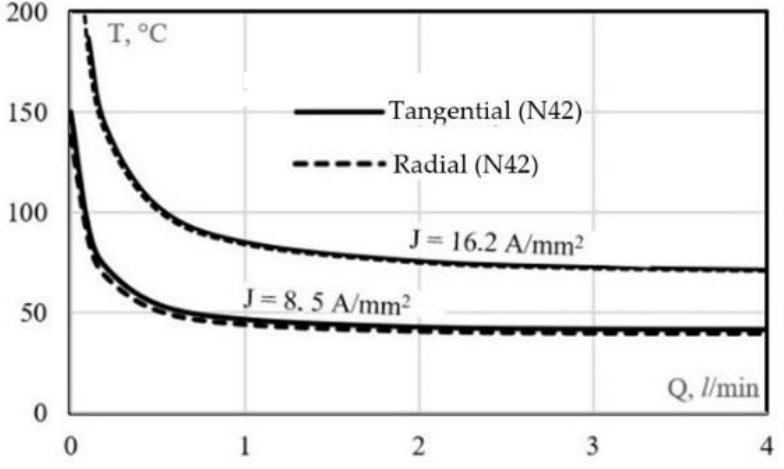
Figure 7. Temperatures of the neodymium magnets (N42) in the tangential and radial machines at various water flow rate of the liquid cooling system. Here, the X -axis defines the flow rate of the system and the Y -axis shows the temperature of the machines.